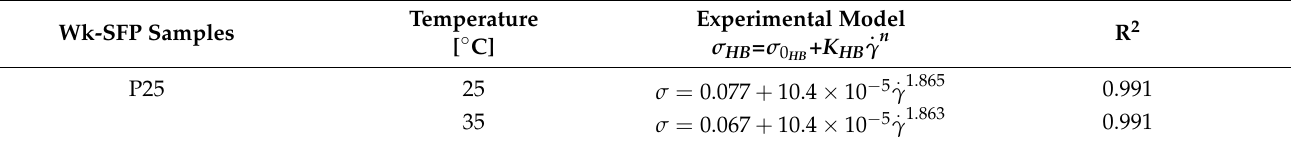
Table 4. Parameters of the steady state analysis of the Herschel–Bulkley model for water kefir (Wk)